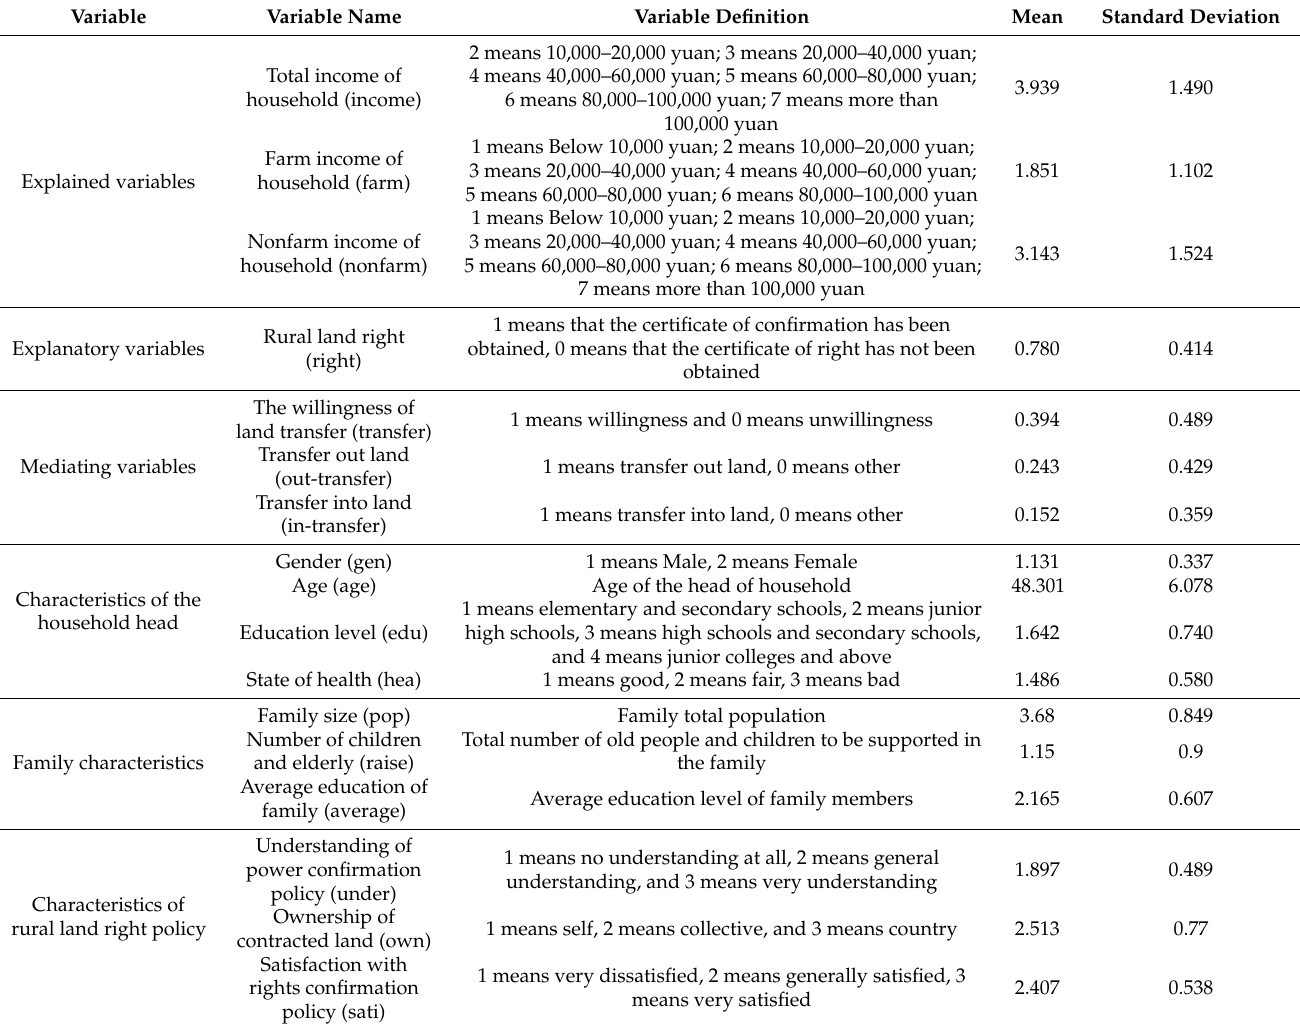
Table 3. Definitions and Descriptions of